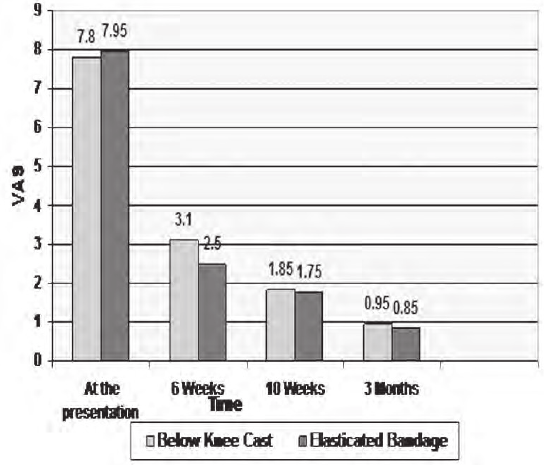
Figure 2: Visual Analogue Score (cid:55)(cid:75)(cid:72)(cid:3)(cid:85)(cid:68)(cid:81)(cid:74)(cid:72)(cid:3)(cid:82)(cid:73)(cid:3)(cid:80)(cid:82)(cid:87)(cid:76)(cid:82)(cid:81)(cid:3)(cid:90)(cid:68)(cid:86)(cid:3)(cid:86)(cid:76)(cid:74)(cid:81)(cid:76)(cid:191)(cid:70)(cid:68)(cid:81)(cid:87)(cid:79)(cid:92)(cid:3)(cid:76)(cid:80)(cid:83)(cid:85)(cid:82)(cid:89)(cid:72)(cid:71)(cid:3)(cid:76)(cid:81)(cid:3)(cid:74)(cid:85)(cid:82)(cid:88)(cid:83)(cid:3) (cid:37)(cid:3)(cid:76)(cid:81)(cid:3)(cid:68)(cid:79)(cid:79)(cid:3)(cid:73)(cid:82)(cid:79)(cid:79)(cid:82)(cid:90)(cid:3)(cid:88)(cid:83)(cid:86)(cid:3)(cid:90)(cid:76)(cid:87)(cid:75)(cid:3)(cid:86)(cid:87)(cid:68)(cid:87)(cid:76)(cid:86)(cid:87)(cid:76)(cid:70)(cid:68)(cid:79)(cid:79)(cid:92)(cid:3)(cid:86)(cid:76)(cid:74)(cid:81)(cid:76)(cid:191)(cid:70)(cid:68)(cid:81)(cid:87)(cid:3)(cid:69)(cid:72)(cid:87)(cid:90)(cid:72)(cid:72)(cid:81)(cid:3)(cid:87)(cid:75)(cid:72)(cid:3) two groups at 6 weeks (p=0.000) and 10 weeks (p=0.017) (cid:73)(cid:82)(cid:79)(cid:79)(cid:82)(cid:90)(cid:3) (cid:88)(cid:83)(cid:86)(cid:3) (cid:68)(cid:81)(cid:71)(cid:3) (cid:86)(cid:87)(cid:68)(cid:87)(cid:76)(cid:86)(cid:87)(cid:76)(cid:70)(cid:68)(cid:79)(cid:79)(cid:92)(cid:3) (cid:81)(cid:82)(cid:87)(cid:3) (cid:86)(cid:76)(cid:74)(cid:81)(cid:76)(cid:191)(cid:70)(cid:68)(cid:81)(cid:87)(cid:3) (cid:68)(cid:87)(cid:3) (cid:22)(cid:3) (cid:80)(cid:82)(cid:81)(cid:87)(cid:75)(cid:3) (p=0.372) and at 6 month (p=0.540) (Figure 2.)